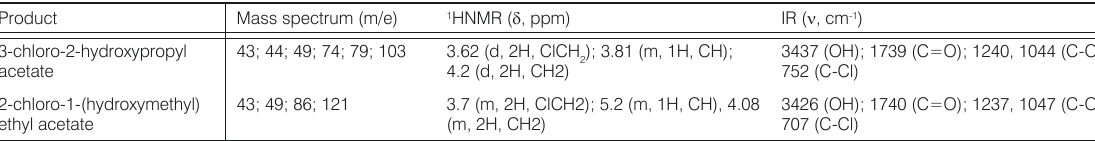
Table 1. Spectral data of